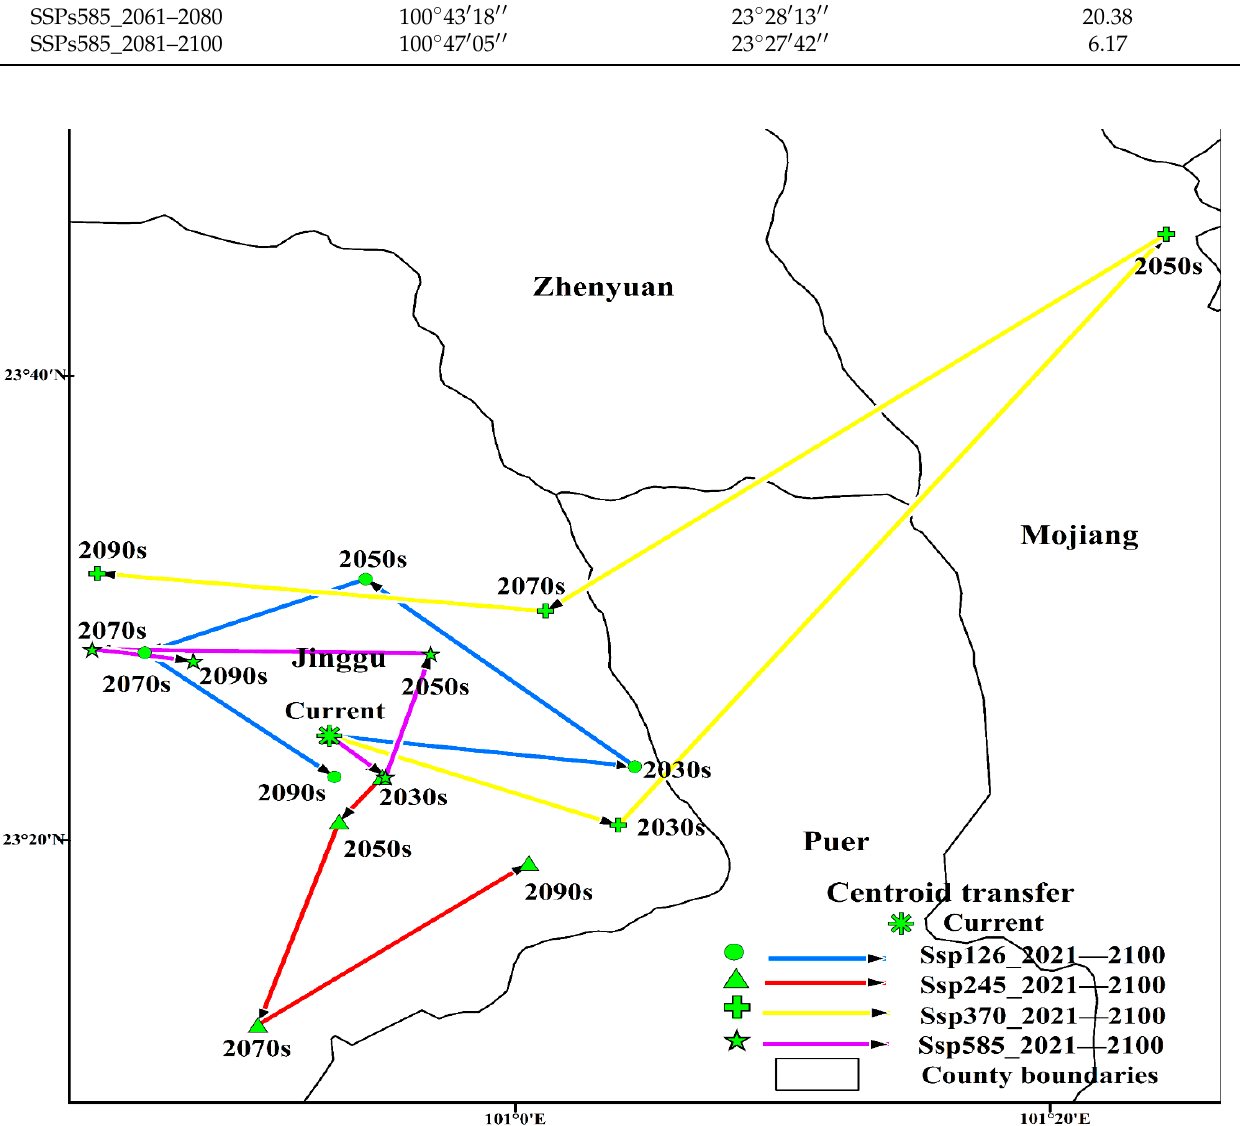
Figure 10. The centroid migration of different periods and different carbon emissions in the pre- sent and in the